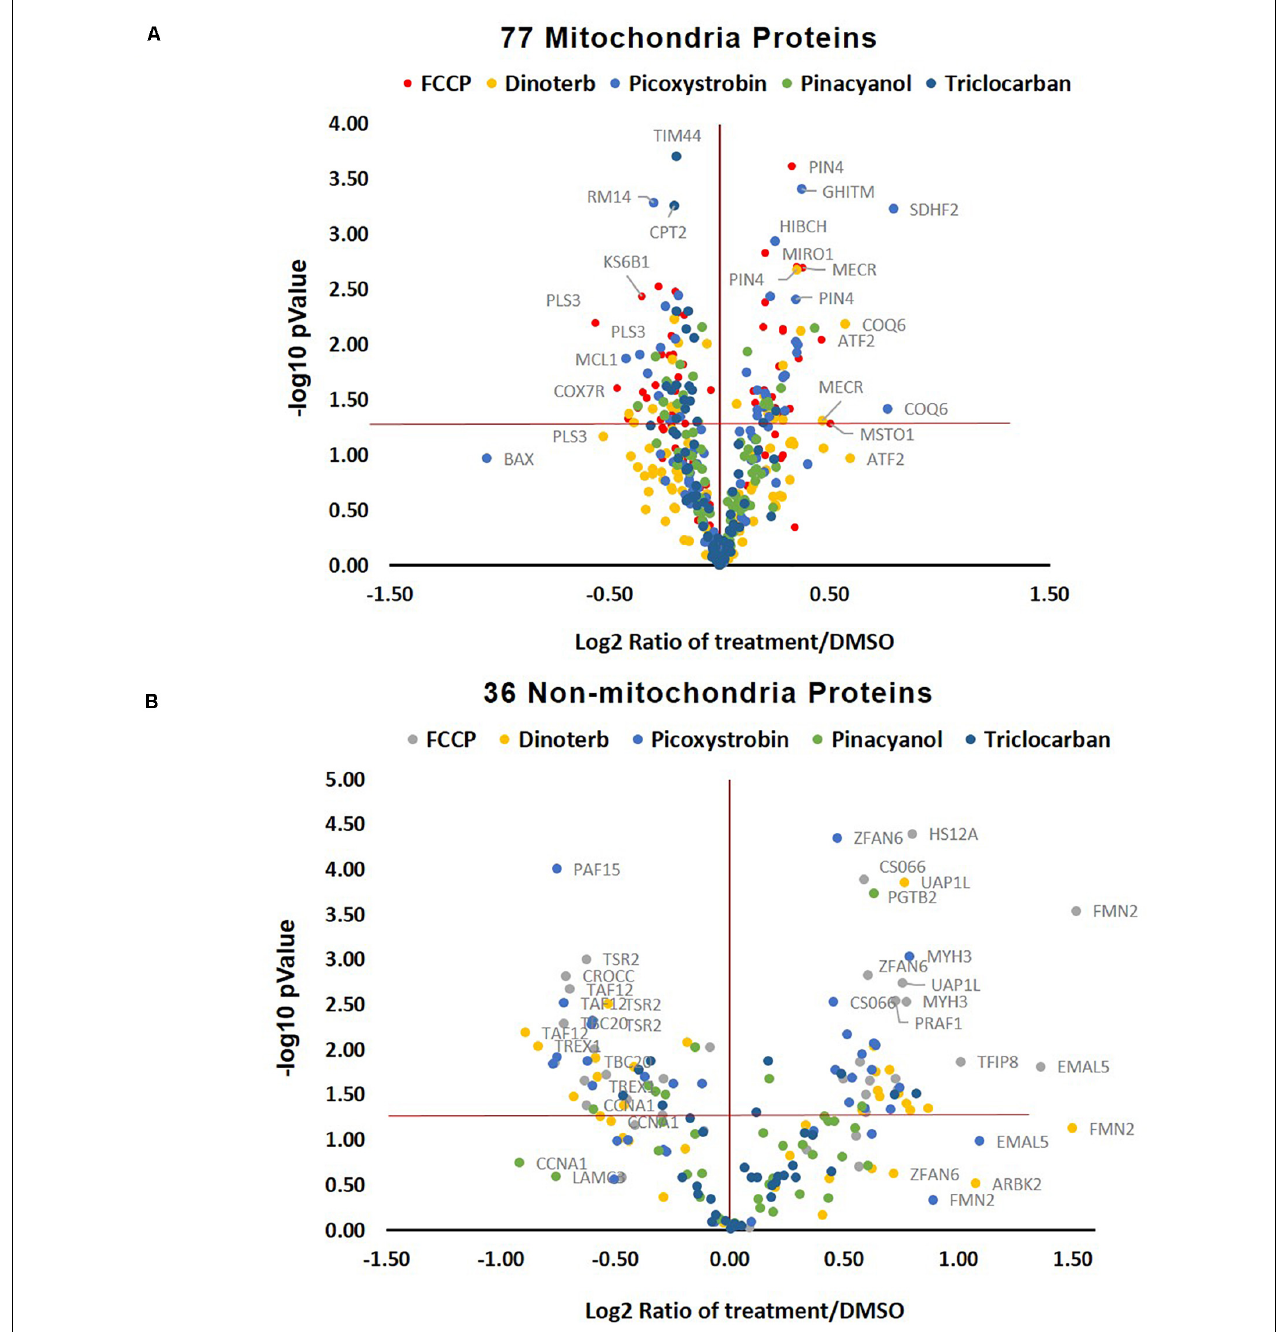
FIGURE 6 | Volcano plot of changed protein expression and p -value upon different treatments. (A) The distribution of ranked 77 mitochondrial proteins. The ranked proteins were significantly ( p < 0.05, n = 3) up/down-regulated 0.15-fold in at least one compound treatment across six groups of 18 samples. (B) The distribution of top ranked 36 non-mitochondrial proteins. The ranked proteins were significantly ( p < 0.05, n = 3) up/down-regulated 0.5-fold in at least one compound treatment across six groups of 18